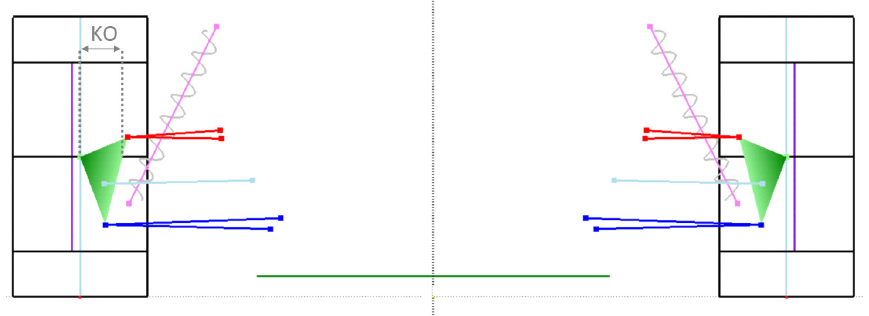
Figure 9. Schematic front view (yz plane) of the original front axle pick-up points. Upper wishbone is shown in red, lower wishbone in blue, upright in green, tie rod in light blue, spring is shown as a pink line with grey coil, the green horizontal line shows the chassis lower plane, rim offset is shown by the vertical purple line.